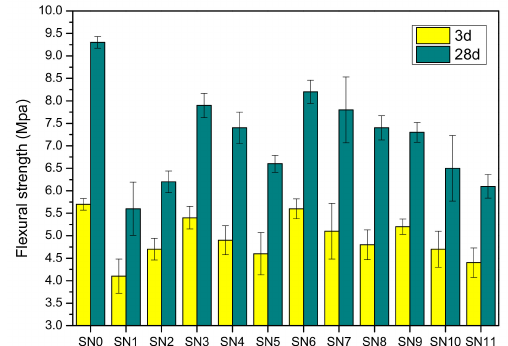
Figure 6. Flexural strength of the cement mortar.